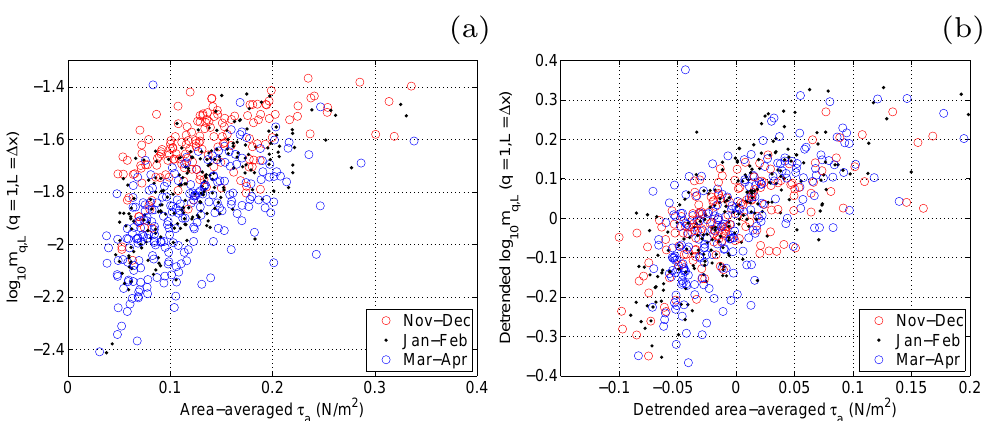
Fig. 2. Scatter plots of ˜ m q,L (for q = 1 and L = 1x ) against ¯ τ a for the original ( a ; C = 0 . 61) and seasonally detrended ( b ; C = 0 . 71) data from the whole analysis period 1996–2008.